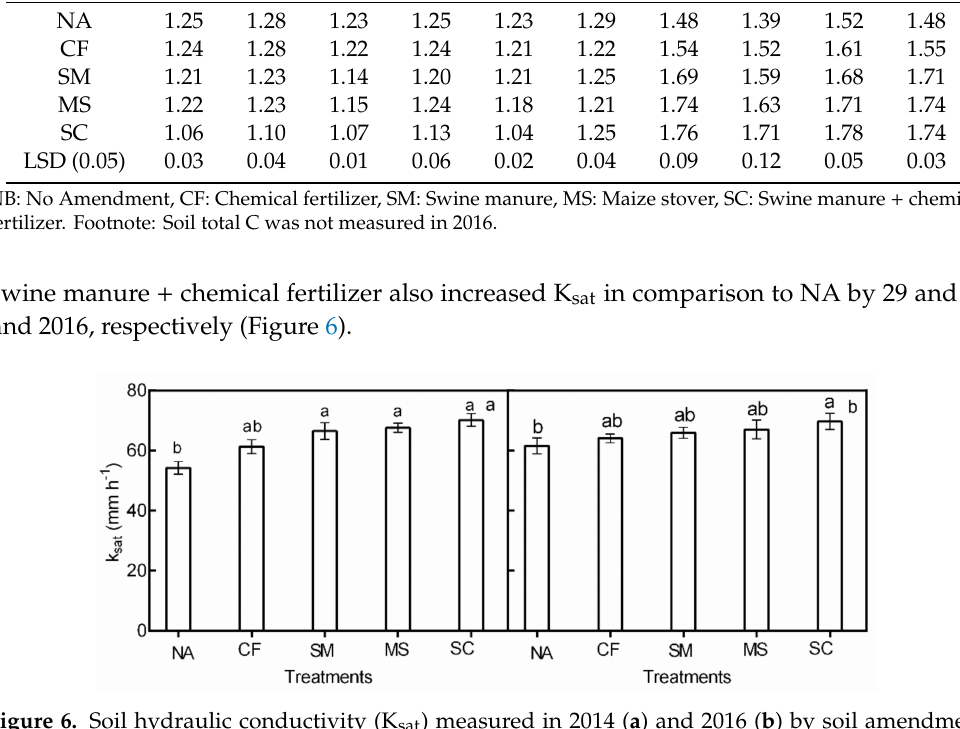
Figure 6. Soil hydraulic conductivity (K sat ) measured in 2014 ( a ) and 2016 ( b ) by soil amendment treatment in maize. NA, no amendment; CF, chemical fertilizer; SM, swine manure; MS, maize stover; and SC, swine manure + chemical fertilizer. Within a year, bars with di ff erent letters are significantly di ff erent ( p ≤ 0.05). Error bars denote standard